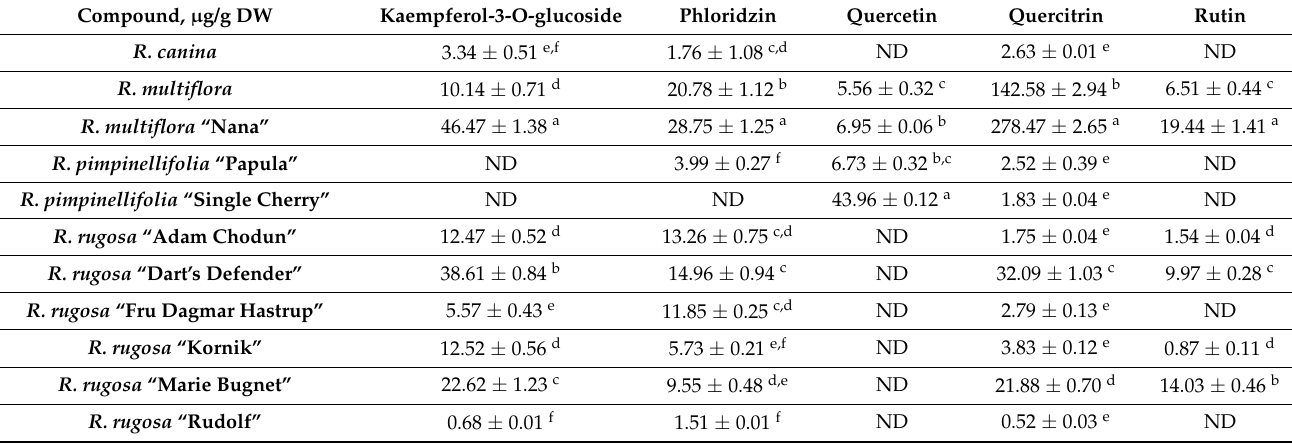
Different letters indicate statistically significant differences in the amounts of individual compounds of these groups in Rosa L. fruit samples ( p < 0.05). ND − Not